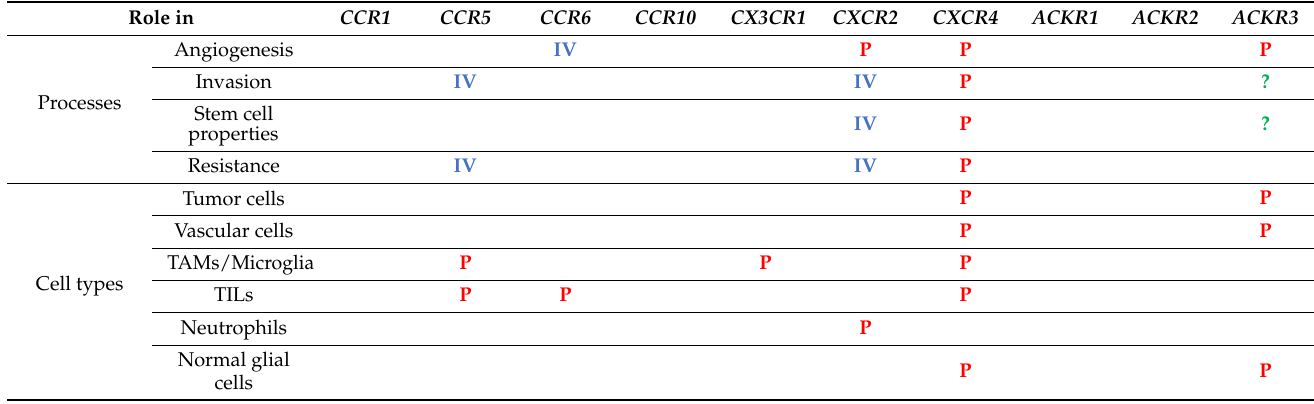
Table 2. Summary of chemokine receptor function in GBM tumorigenic processes and in GBM